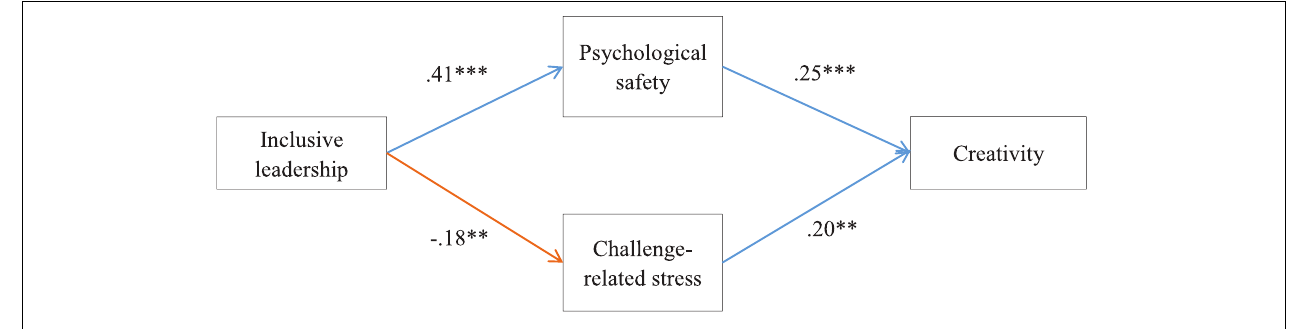
FIGURE 2 | Results of theoretical model by using Mplus. N = 244, ∗∗ p < 0.01, ∗∗∗ p < 0.001. Standardized path coefficients are reported. Control variables are gender, age, marry, tenure, education, and